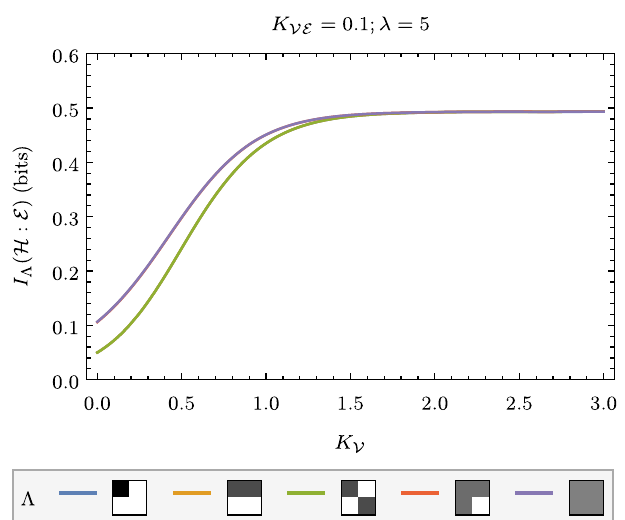
FIG. 7. Mutual information I Λ ð H ∶ E Þ in the toy model of a 2D system Eq. (26) as a function of the coupling K V between the visibles. The coupling pattern to the visibles in different RG rules Λ is shown schematically in the (physically relevant) large- jj Λ jj 2 limit. The majority rule (and interestingly, also coupling to three spins depicted by a red line coinciding with the purple one) consistently retains more information than decimation or any coupling to two spins (blue and yellow coinciding with green). Again, the distinction vanishes for large K V when all visible spins are bound into a single